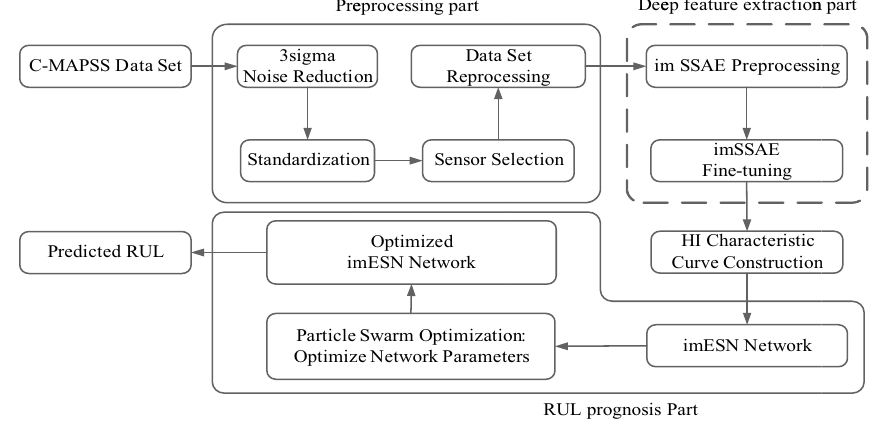
Figure 1. The framework of the proposed